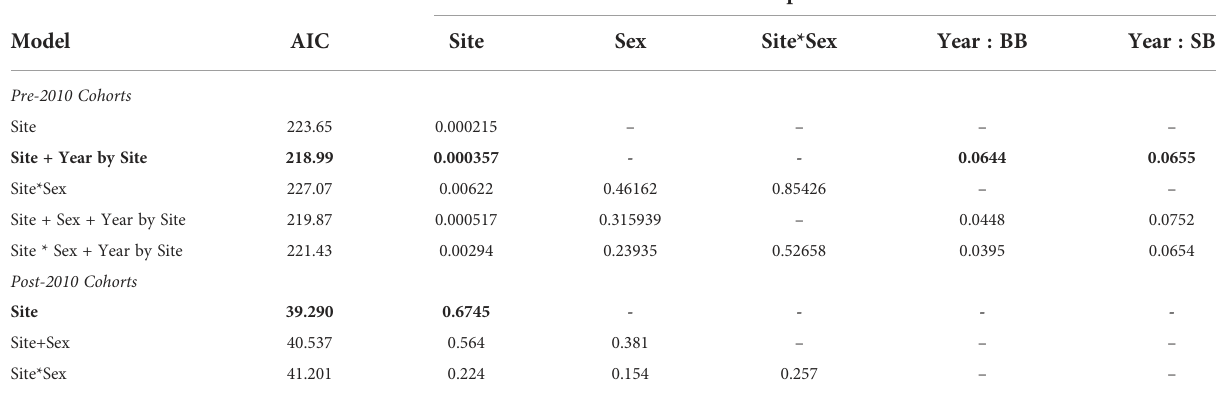
TABLE 1 Results from the generalized additive model analysis (pre-2010 cohorts) and generalized linear model analysis (post-2010 cohorts) of overall lung